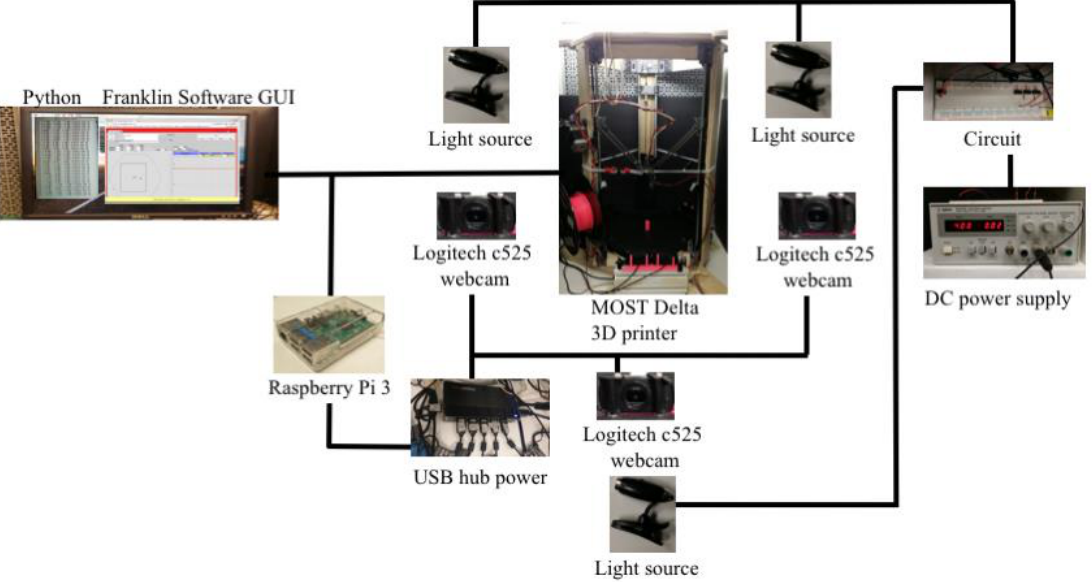
Figure 1. MOST (Michigan Tech Open Sustainability Technology) Delta printer experimental setup where three pairs of cameras were placed around the 3-D printer 120 degrees apart then all six images were processed by our Python-algorithms on Raspberry Pi3.